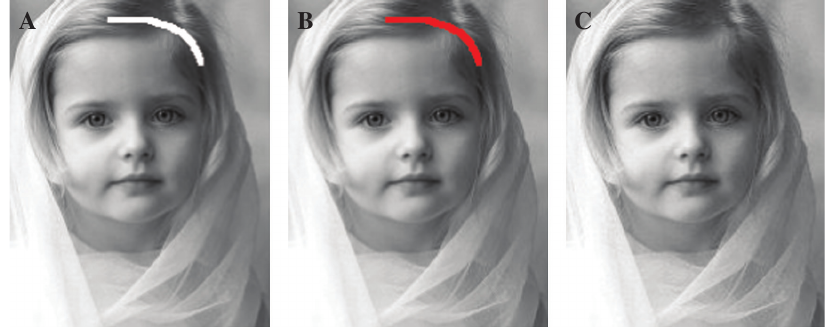
Figure 8. Nice2: Patch Size 9 × 9.